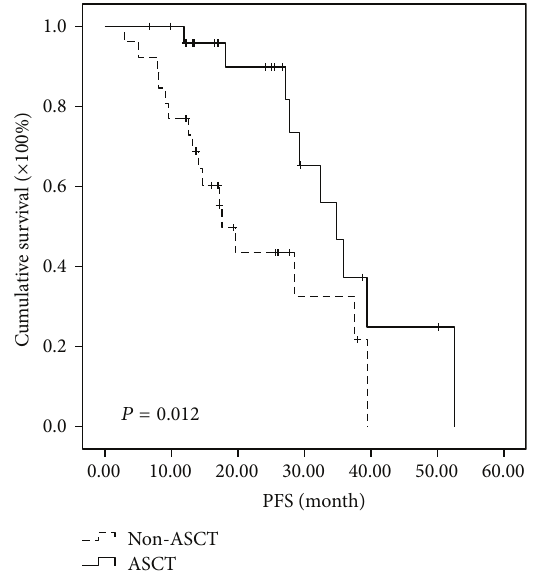
Figure 8: Comparison of PFS in the patients of ASCT group and non-ASCT group in the low-risk subgroup. The median OS was 58.8 versus 76 months with no significant difference ( 𝑃 = 0.069